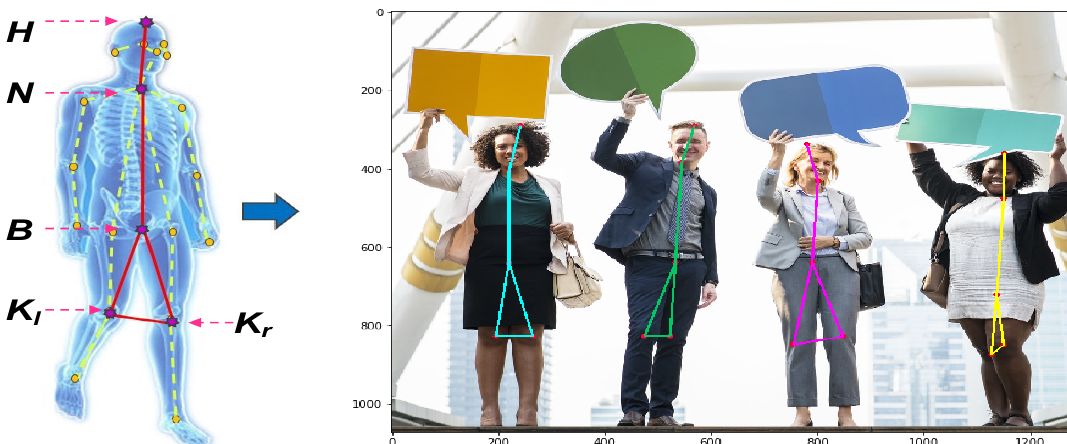
Figure 2. Five-point inverted pendulum model. The left model indicates COCO model [2] that includes 18 key parts of orange color and the yellow dotted line for human skeleton and five-point inverted pendulum model that includes five purple stars and the red real line for human skeleton. In the test, different moving objects (or different persons) indicated by a five-point inverted pendulum model are shown with different